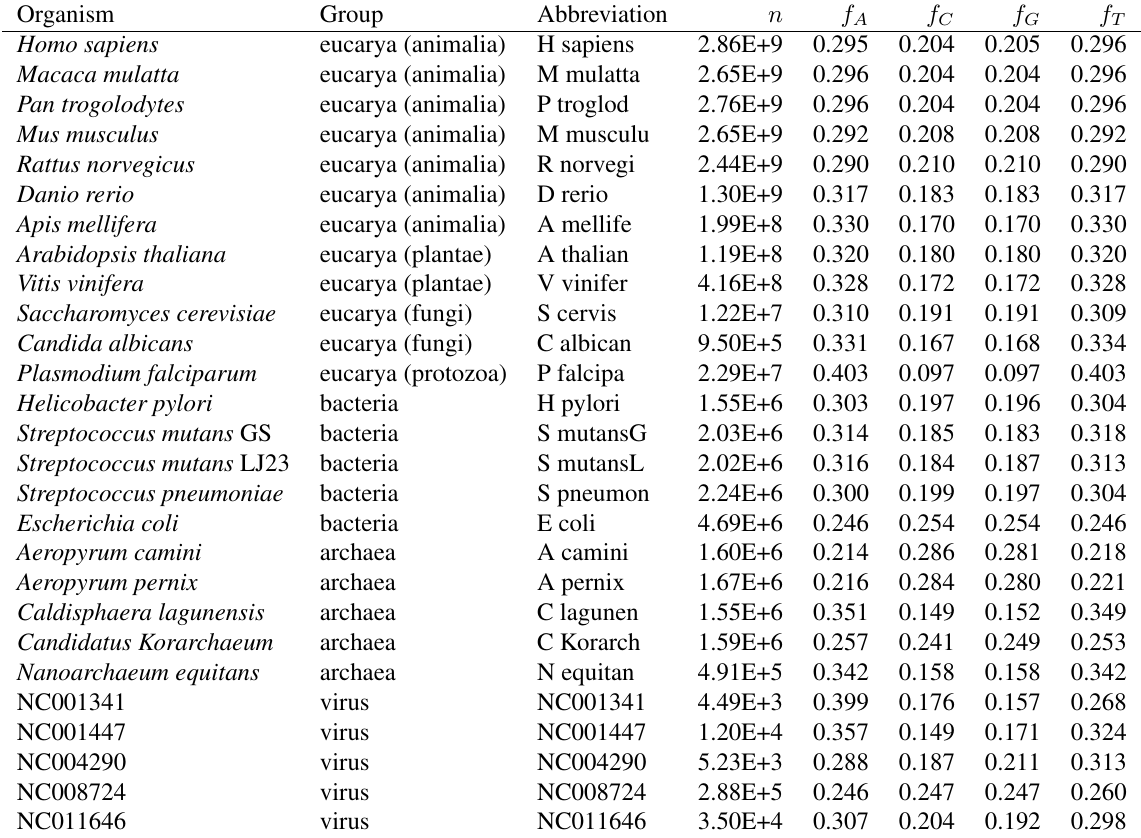
Table 1: List of organisms whose DNA was used in this study. Genome length n and measured nucleotide composition are